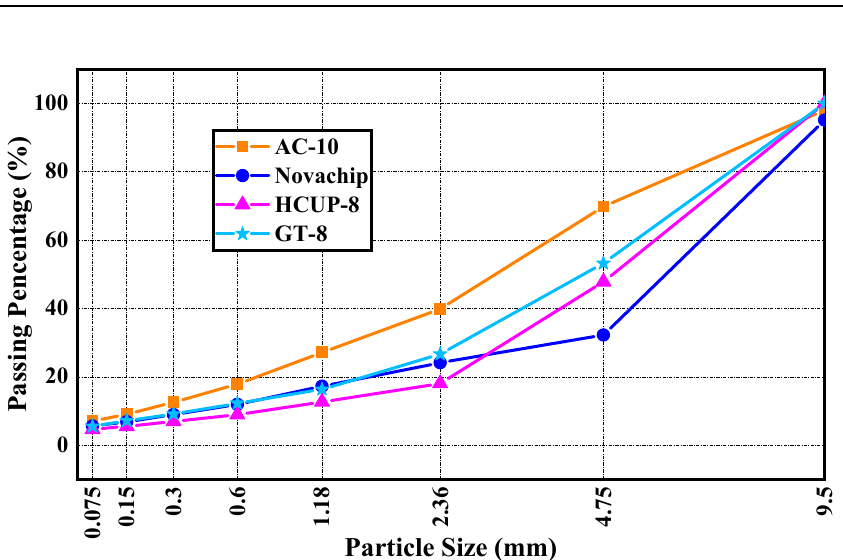
Figure 1. Grading curve of AC-10, Novachip, HCUP-8 and GT-8.